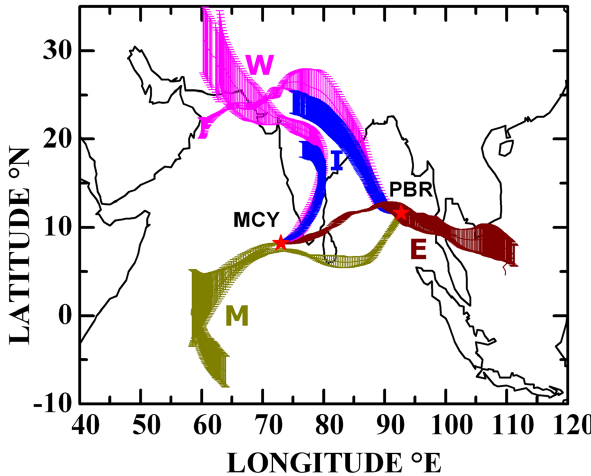
Fig. 30. Back trajectory groups arriving at 1800ma.s.l. over Mini- coy Island (MCY) and Port Blair (PBR) during April 2006. The vertical bars over the mean line show the spatial spread of each group. The regions of origin are: “E” – Eastern Asia; “I” – India; “W” – Western Asia and Arabia; “M” – marine (from Beegum et al., 2008, copyright 2008 by the Indian Academy of Sciences, re- produced with permission).